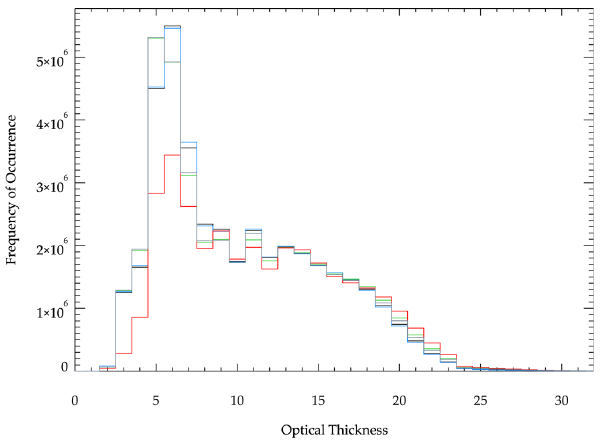
Fig. 10. Histogram of the optical thickness retrieved with different constraints of the effective radius. (1) black, (2) blue, (3) green, (4) red, (5) grey.